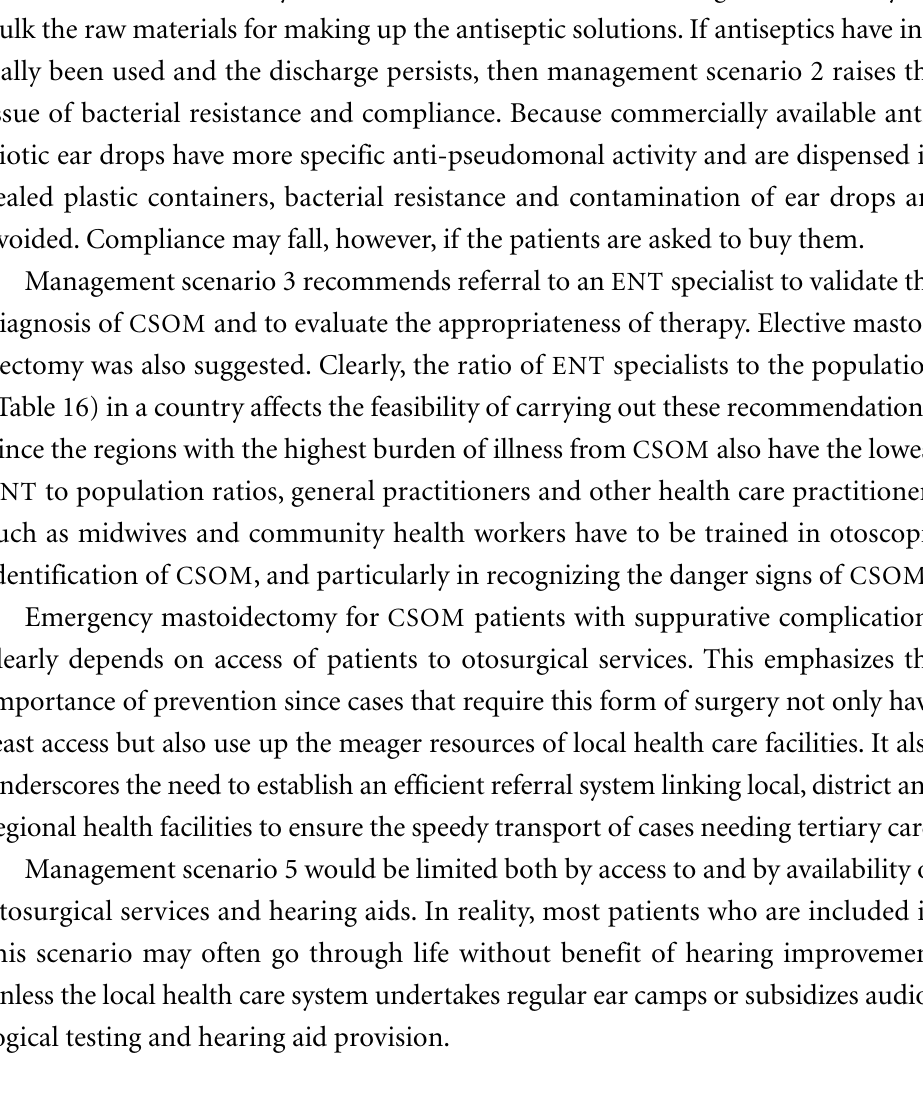
Table 16. Regional distribution of ENT specialists per million population